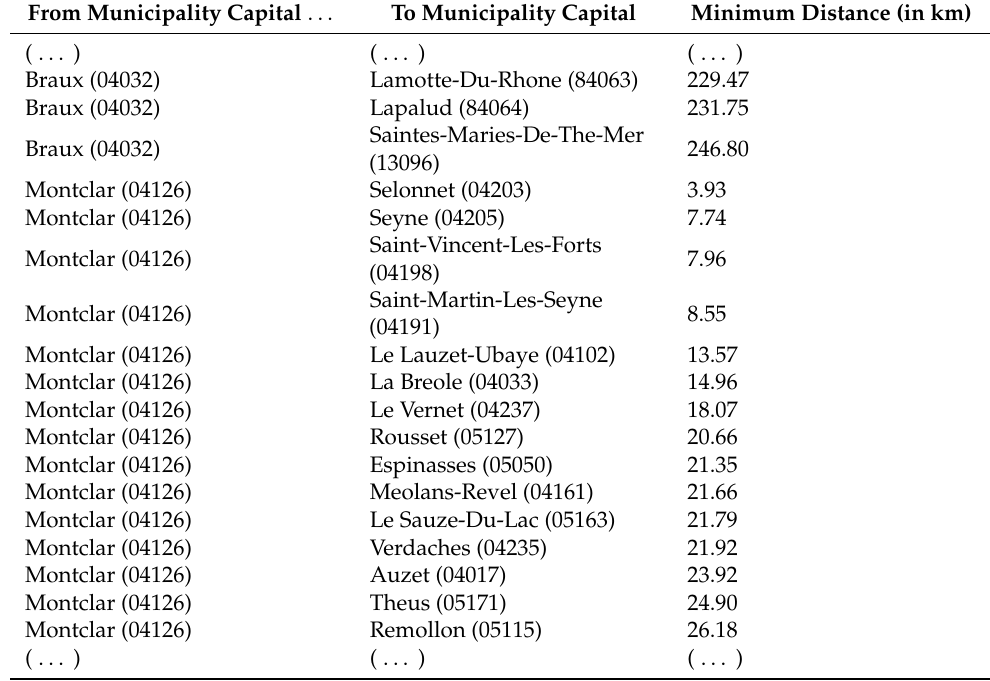
Table 4. Partial view of the matrix of distances between municipalities in Department 04 (this is the end of the list for Braux and the start of the list for Montclar). For each municipality, the list of distances is sorted in increasing order. This table for Department 04 contains about 190,000 entries. From Municipality Capital . . . To Municipality